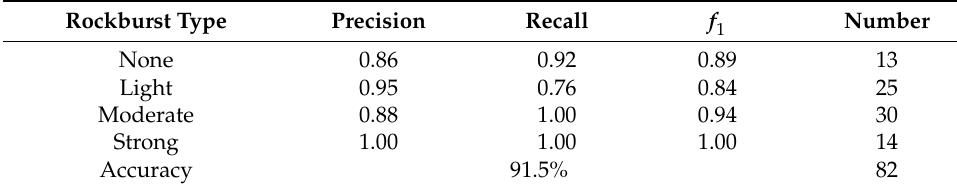
Table 8. The testing performance of DF models with Tr (75%)-Te (25%).